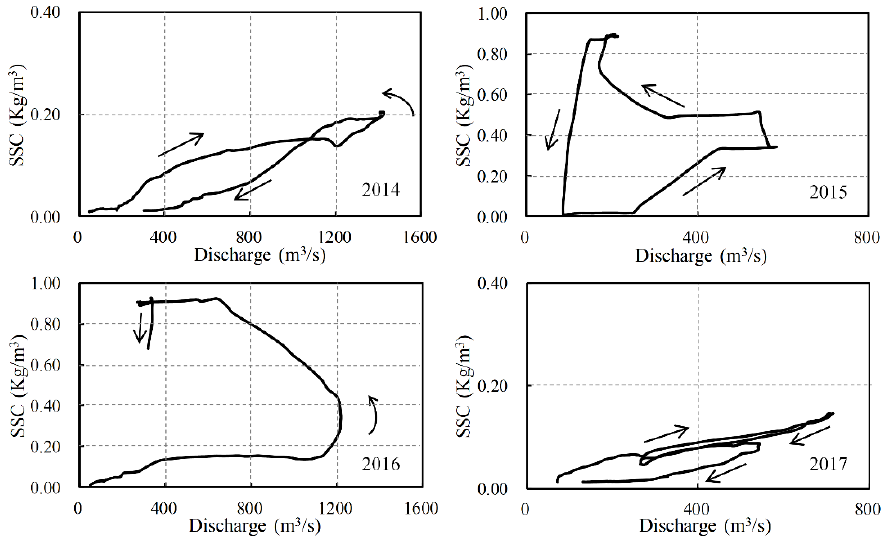
Figure 7. Q-SSC hysteresis in the Lhasa River.